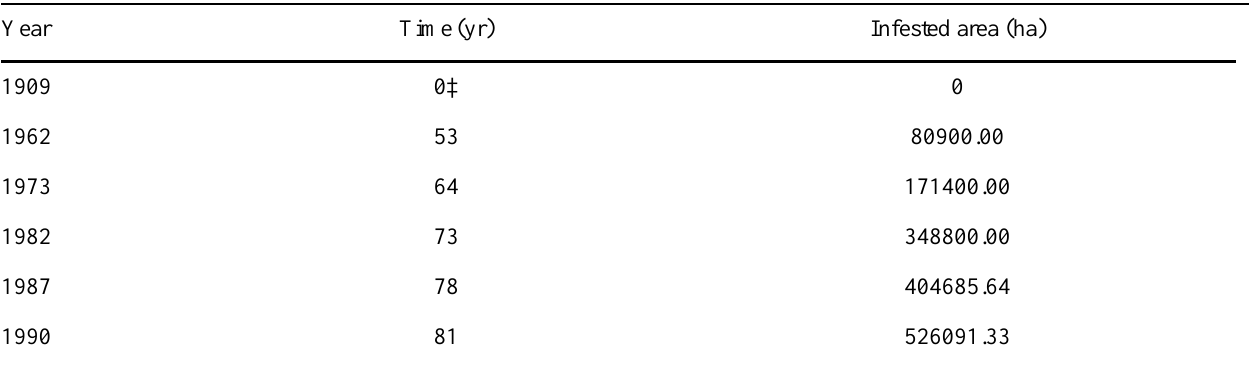
Table 1. Spread of leafy spurge in North Dakota,